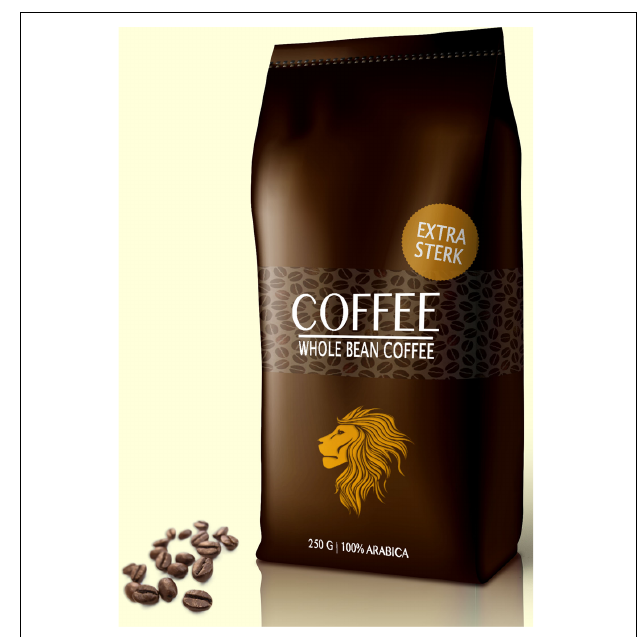
TABLE 1 | Demographic characteristics of participants per experimental condition.